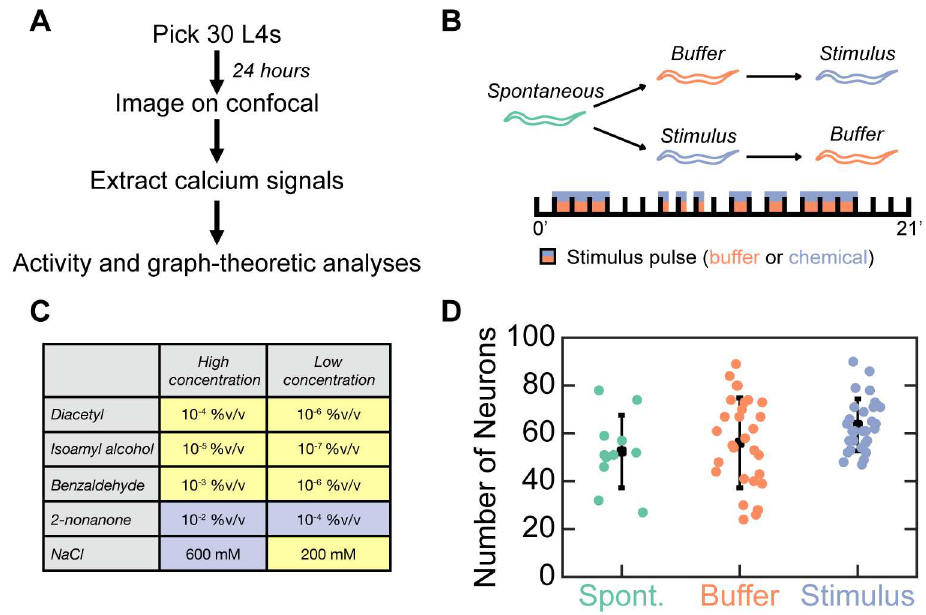
Fig 1. Whole-brain imaging experiments and analysis. A) Schematic showing the experimental protocol. Thirty stage L4 animals were picked onto a plate covered with OP50 24 hours before each experiment. Animals, as 1-day old young adults, were stimulated in an olfactory chip and their neural responses were imaged on a Zeiss Airyscan 880. Fluorescence traces were extracted from each video, and subsequently analyzed. B) Animals were imaged in three 21 minute-long sessions: Spontaneous, Buffer, and Stimulus. Buffer and Stimulus sessions had seven pulses of M9 buffer or one of 10 chemicals, respectively (indicated by the dual-color shading). Animals only experienced M9 buffer or a single chemical stimulus on any given 21-minute long session using an identical stimulus protocol (see dual-color boxes). C) Table showing the chemicals (attractants are colored yellow, repellents are violet) and concentrations tested. Three animals were tested per stimulus condition. %v/v refers to % vol/vol. D) We recorded a similar number of neurons during Spontaneous (green), Buffer (orange), and Stimulus (blue) sessions (p = 0.0947 by Kruskal-Wallis test). Each color dot is the number of neurons recorded in a single worm, and the black squares and lines indicate the mean and standard deviation for a given session type. N = 12, 30, and 30 animals for Spontaneous, Buffer, and Stimulus sessions,